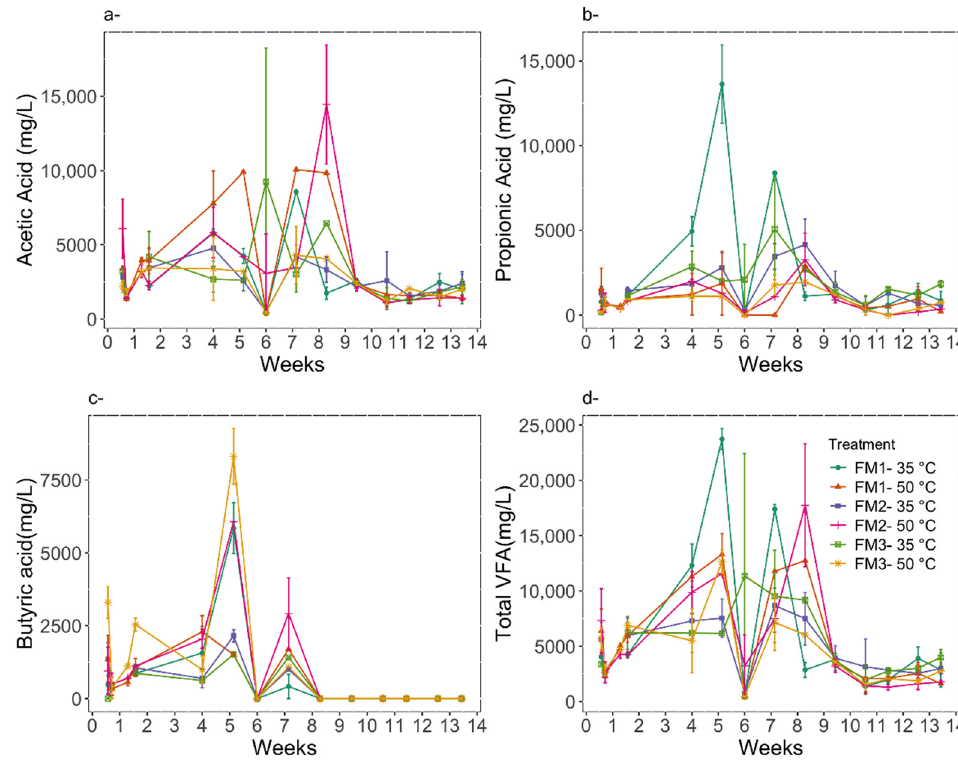
Figure 2. Volatile fatty acid (VFA) concentrations throughout the experiment. ( a ) Acetic acid. ( b ) Propanoic acid. ( c ) Butyric acid. ( d ) Total VFA. Each data point is the average of two replicates and error bars show the standard error.